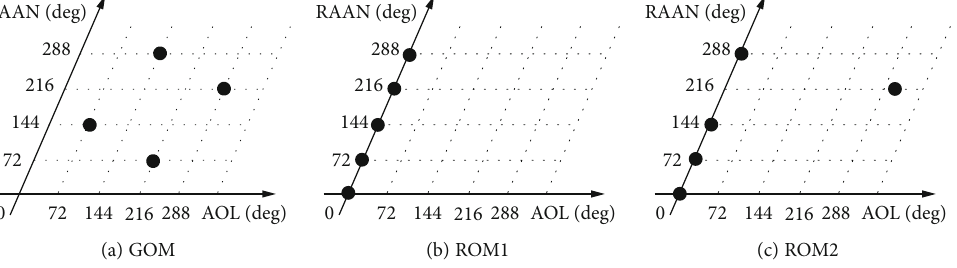
Figure 10: Con fi gurations of di ff erent constellations.